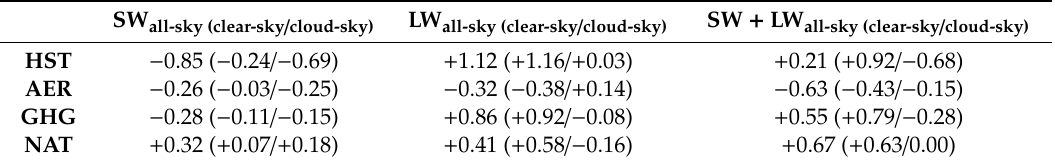
Table 3. The land-mean linear trend (Wm − 2 decade − 1 ) of the JJA-mean downwelling SW, LW, and the net radiation at the surface from the HST, AER, GHG, and NAT simulations for P1. The numbers in the parenthesis are the corresponding values for the clear-sky and cloudy-sky condition.